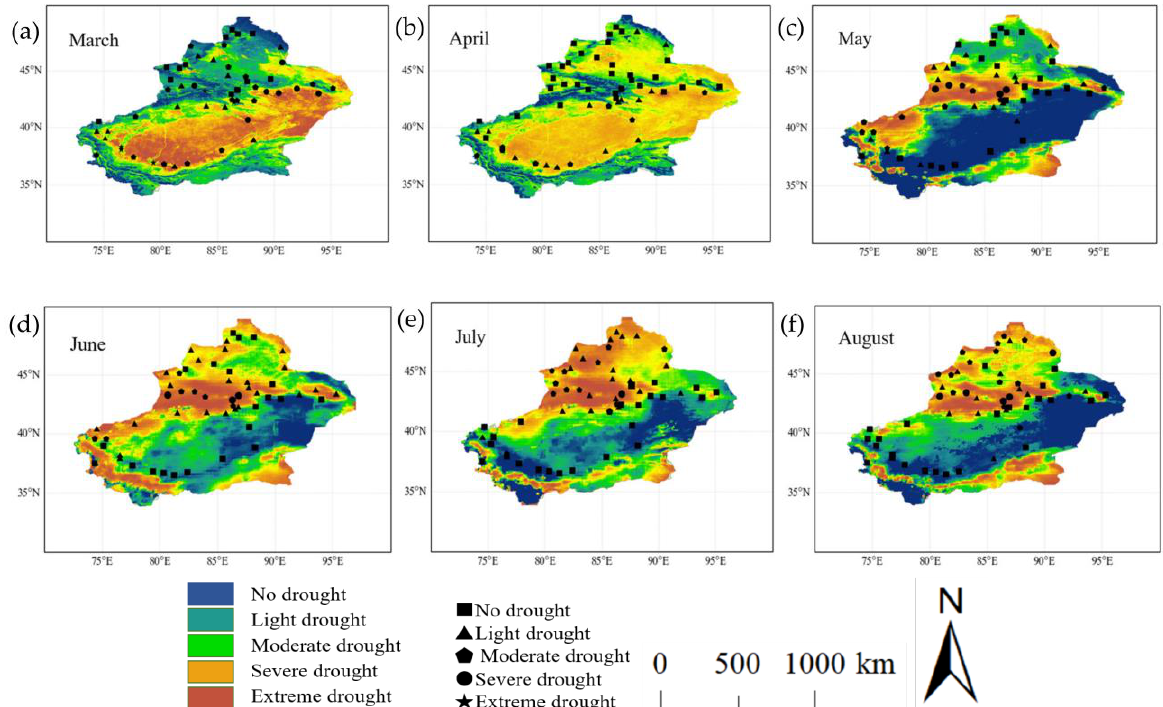
Figure 6. ( a – f ) are Spatial distribution of CDI-6 from ConvLSTM model with station drought distri- bution during March – August 2014.